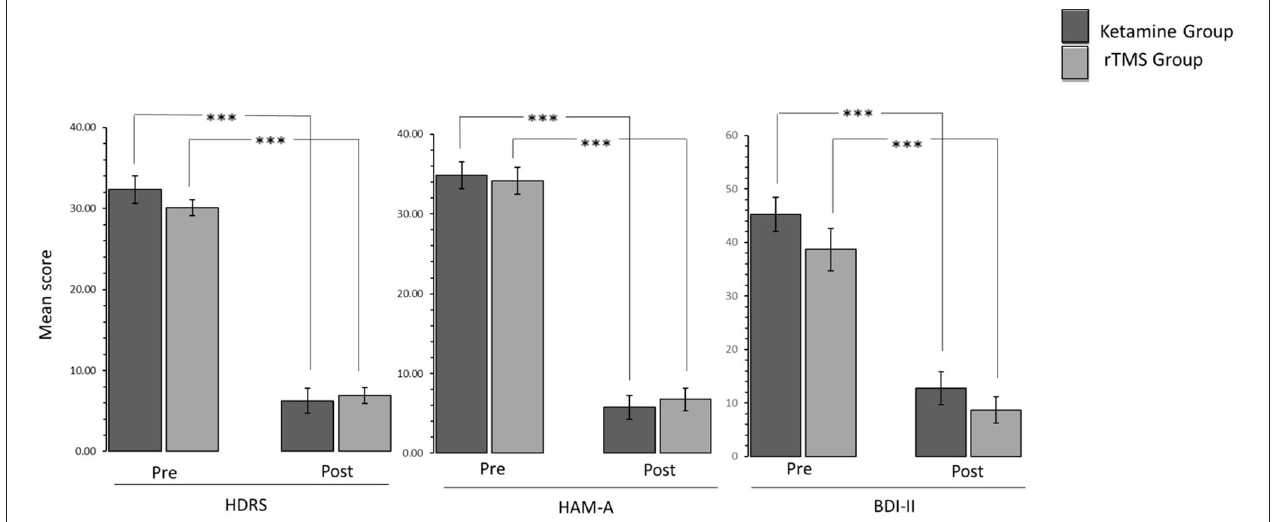
FIGURE 1 | Bar graphs showing difference in pre-treatment and post-treatment scores of patients in Ketamine and rTMS groups. Error bars indicate standard error. *** P <